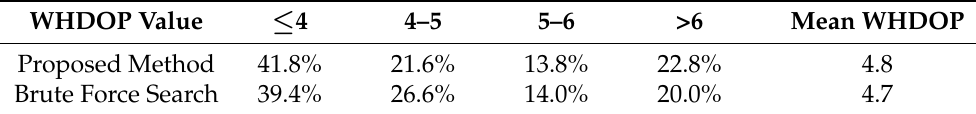
Figure 4. Comparison of the results of brute force search ( top ) and the proposed algorithm ( bottom ). Table 2. Distribution of WHDOP values using different methods under four